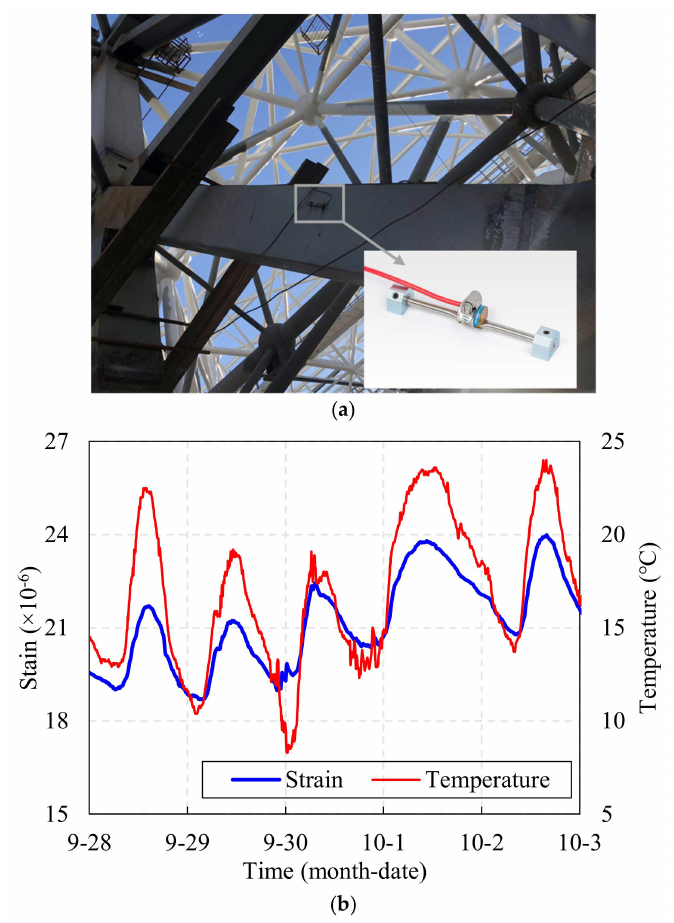
Figure 3. Arc weldable vibrating wire strain gauge of a space grid steel structure. ( a ) Photos of the on-site installation, ( b ) temperature and strain data for a